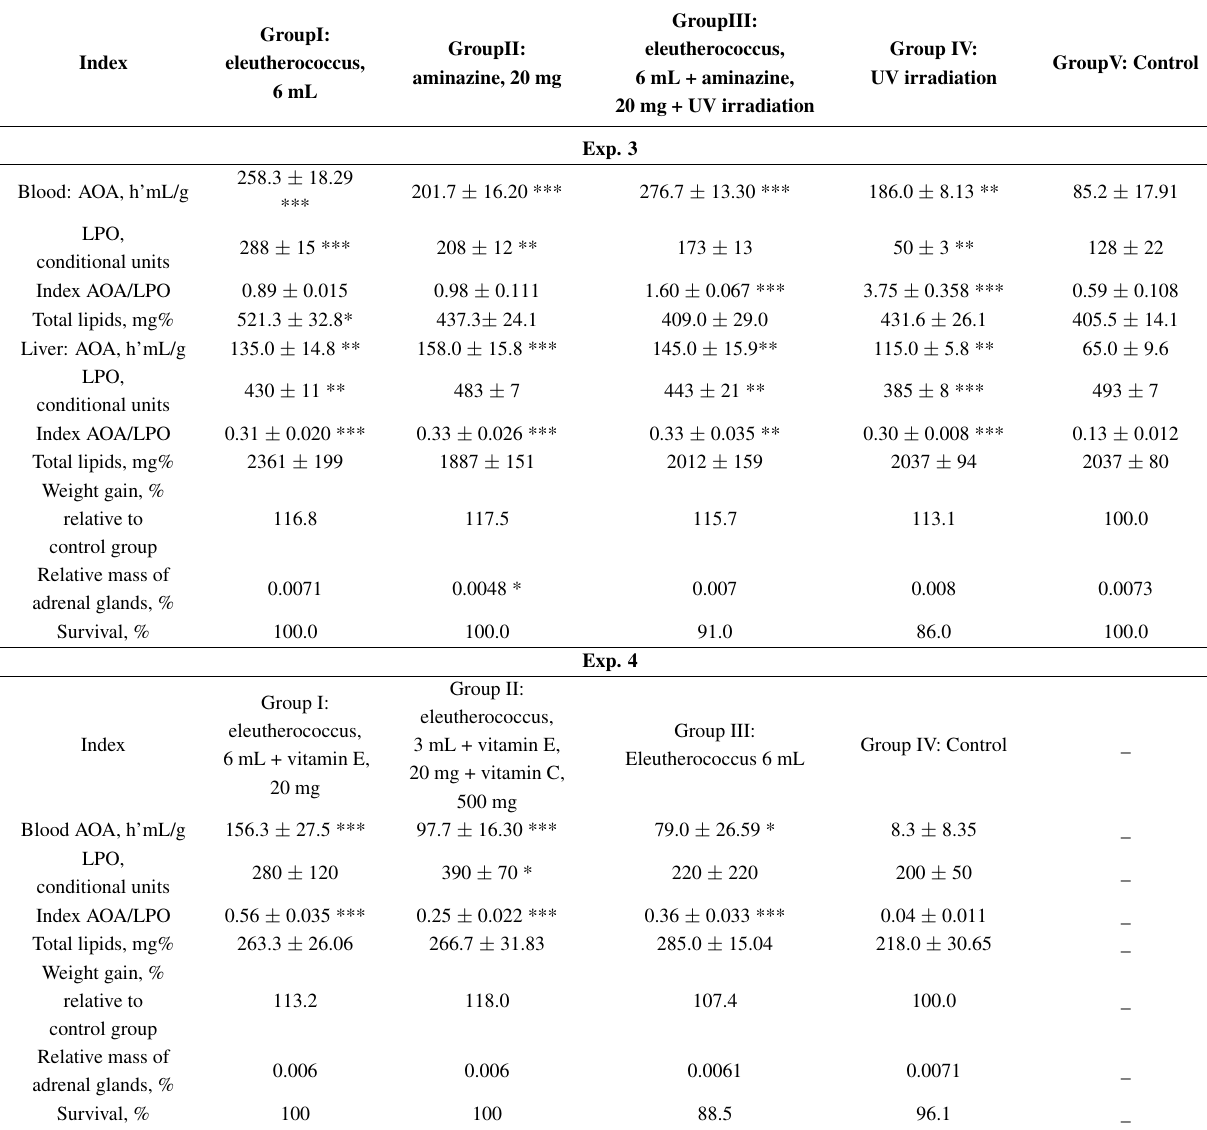
influence of vitamins C, E, eleutherococcus extract, UV irradiation and